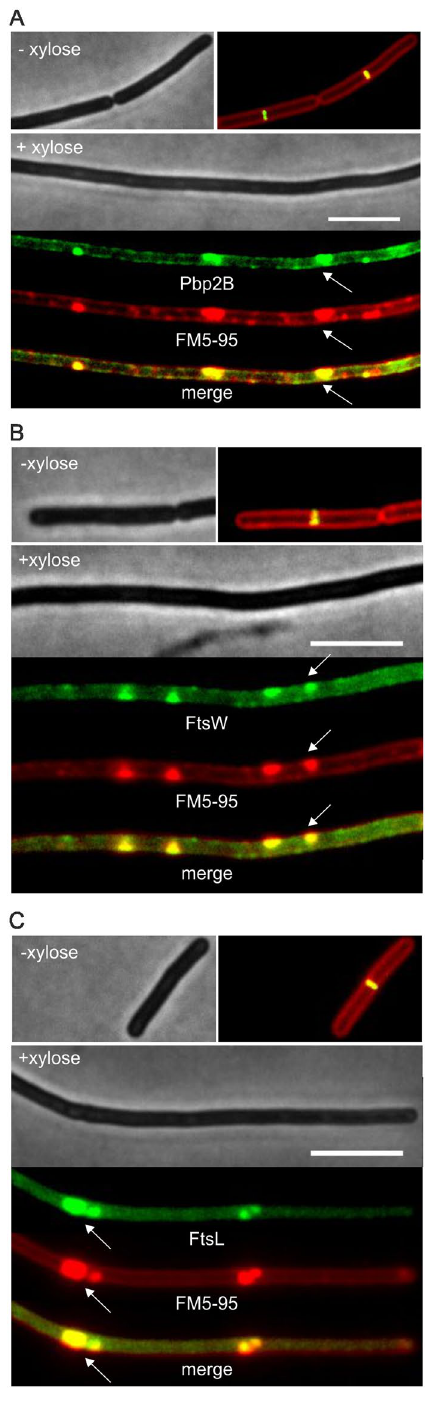
Figure 4. Effect of SepF overexpression on Pbp2B, FtsW and FtsL localization. Microscopic images of ( A ) strain GYQ72 ( amyE:: P xyl-sepF aprE:: P spac-gfp-pbpB ) expressing GFP-Pbp2B, ( B ) strain GYQ74 ( amyE:: P xyl- sepF aprE:: P spac-gfp-ftsW ) expressing GFP-FtsW, and ( C ) Strain GYQ204 ( amyE:: P xyl-sepF aprE:: P spac-gfp- ftsL ) expressing GFP-FtsL, grown in the absence ( − ) or presence ( + ) of 1% xylose to induce SepF expression. Membranes were fluorescently stained with FM5-95. Scale bar is 5 µ